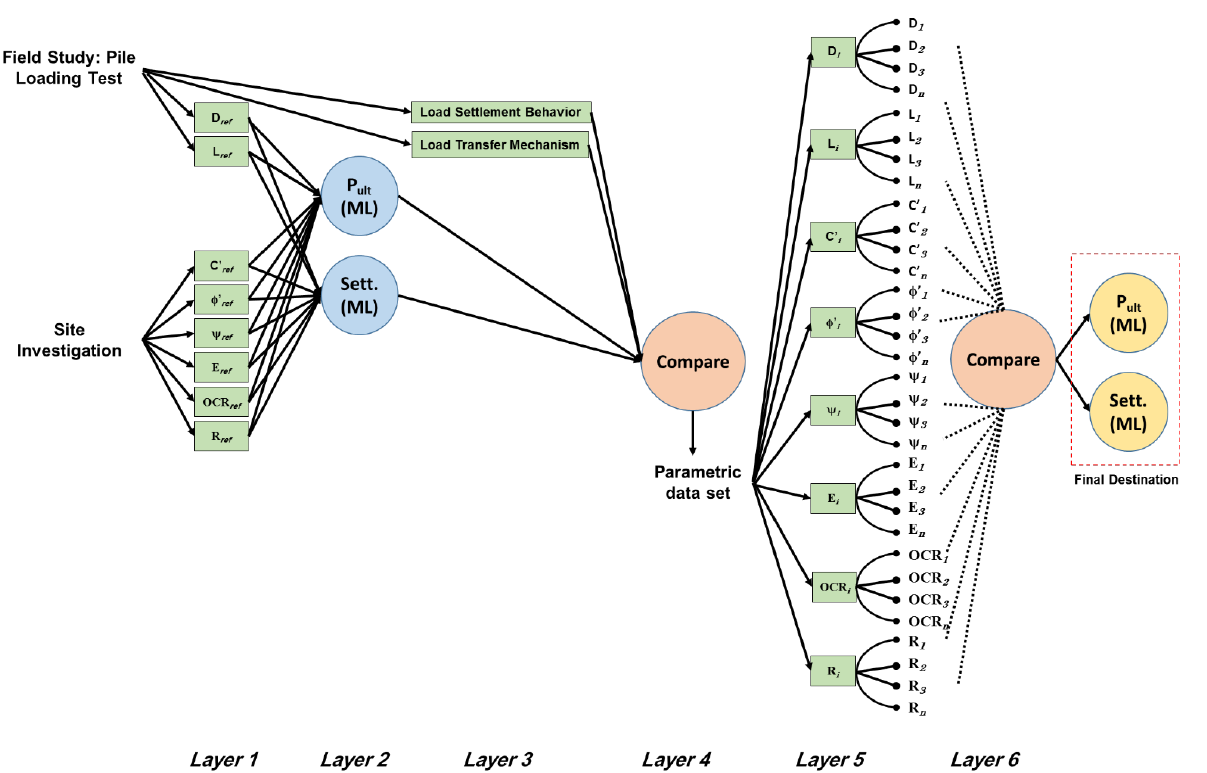
Figure 13. The suggested decision tree of a supervised machine learning algorithm for predicting the ultimate capacity of LDBP.